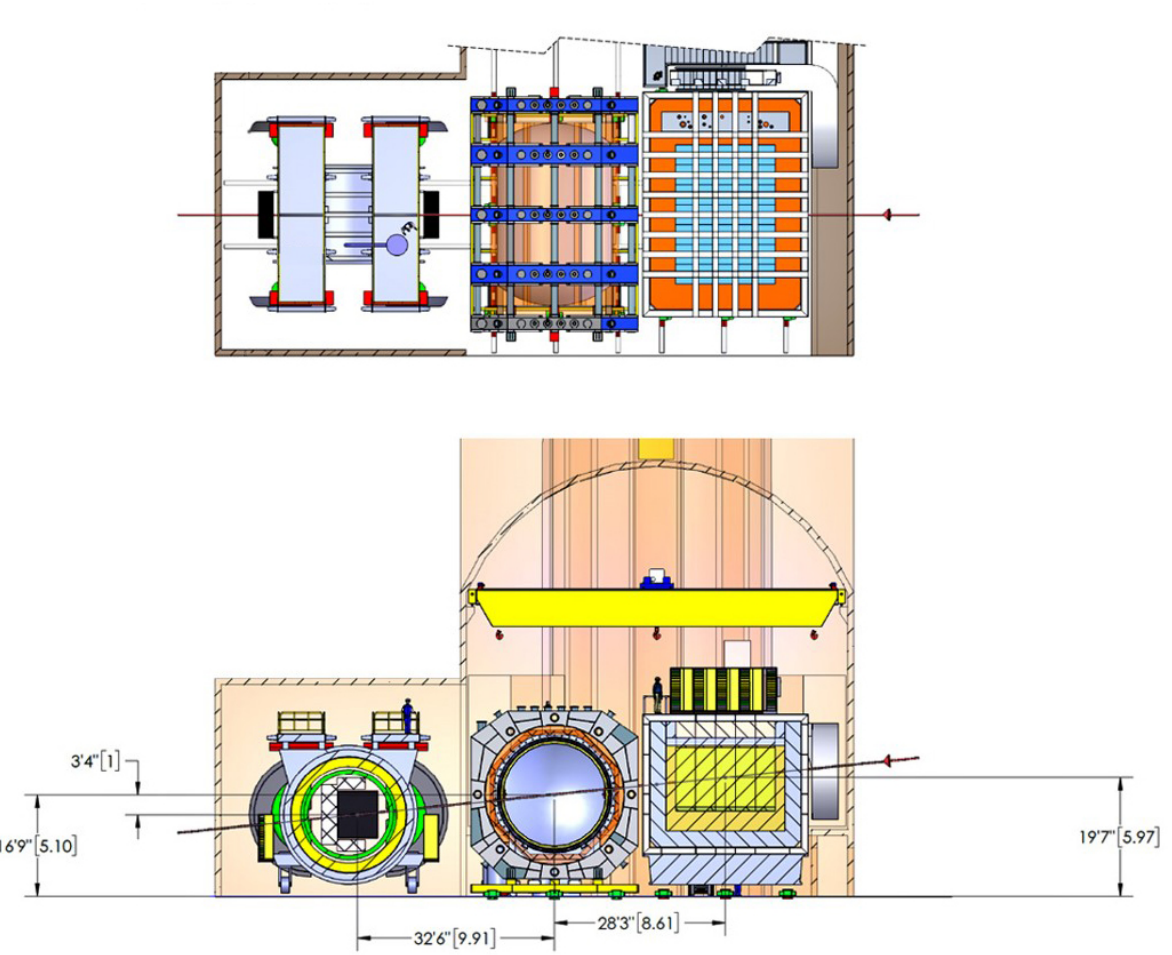
Figure 168. Near detector positions relative to the cavern and the DUNE neutrino beamline which passes through the center of each detector active volume.